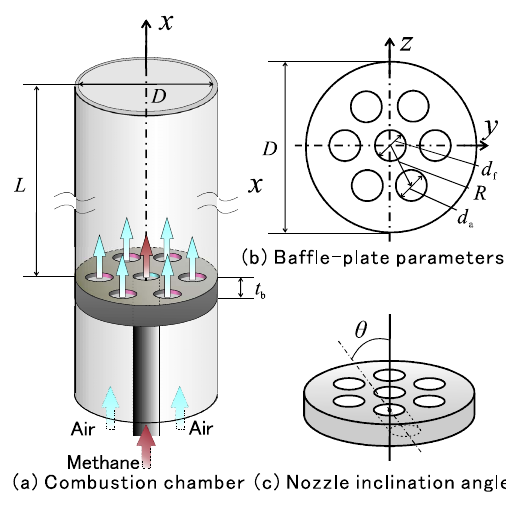
Fig. 1 Schematic of baffle-plate type multi-jet